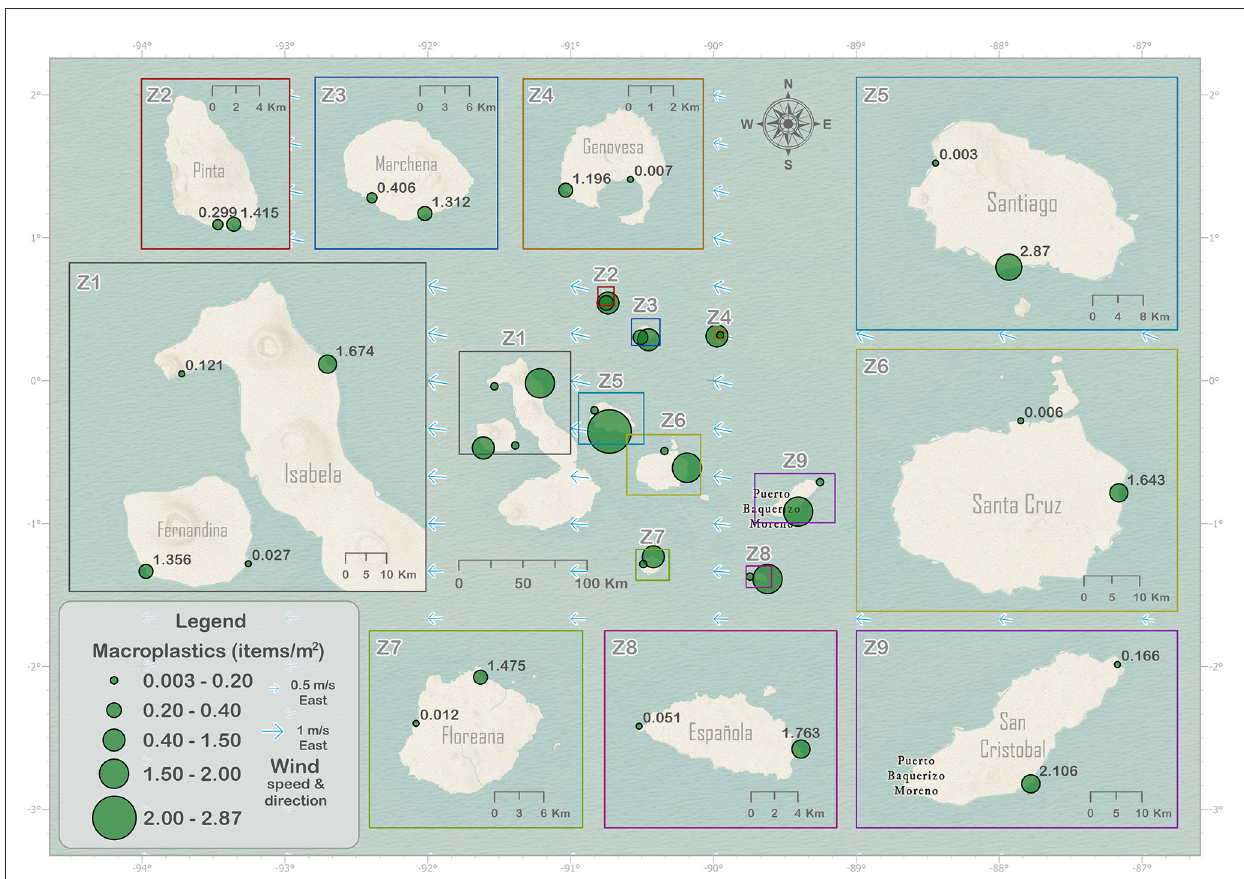
FIGURE3 Macroplastic total density (items/m 2 ) for all sample sites in the Galápagos Archipelago. In the map, we divided our sample sites into 9 Zones/Islands (Z) to improve data visualization. Z1: Fernandina and Isabela Island; Z2: Pinta island; Z3: Marchena island; Z4: Genovesa island; Z5: Santiago Island; Z6: Santa Cruz Island; Z7: Floreana island; Z8: Española Island; Z9: San Cristóbal Island. Wind data were derived from the Global Ocean Data Assimilation (SODA) dataset, which is a part of the Global Ocean Data Assimilation System (GODAS), from the National Oceanic and Atmospheric Administration (NOAA) of the US. The u and v components of the wind currents over the oceans were plotted on a grid of 0.5 ◦ arc-degree over the Galápagos area, and the yearly average was presented as the wind speed and direction. The range of wind speeds was between 0.1 and 1 m/s. The predominant wind direction throughout the year is NWW at most locations in Galápagos, south of the equator (NCAR,